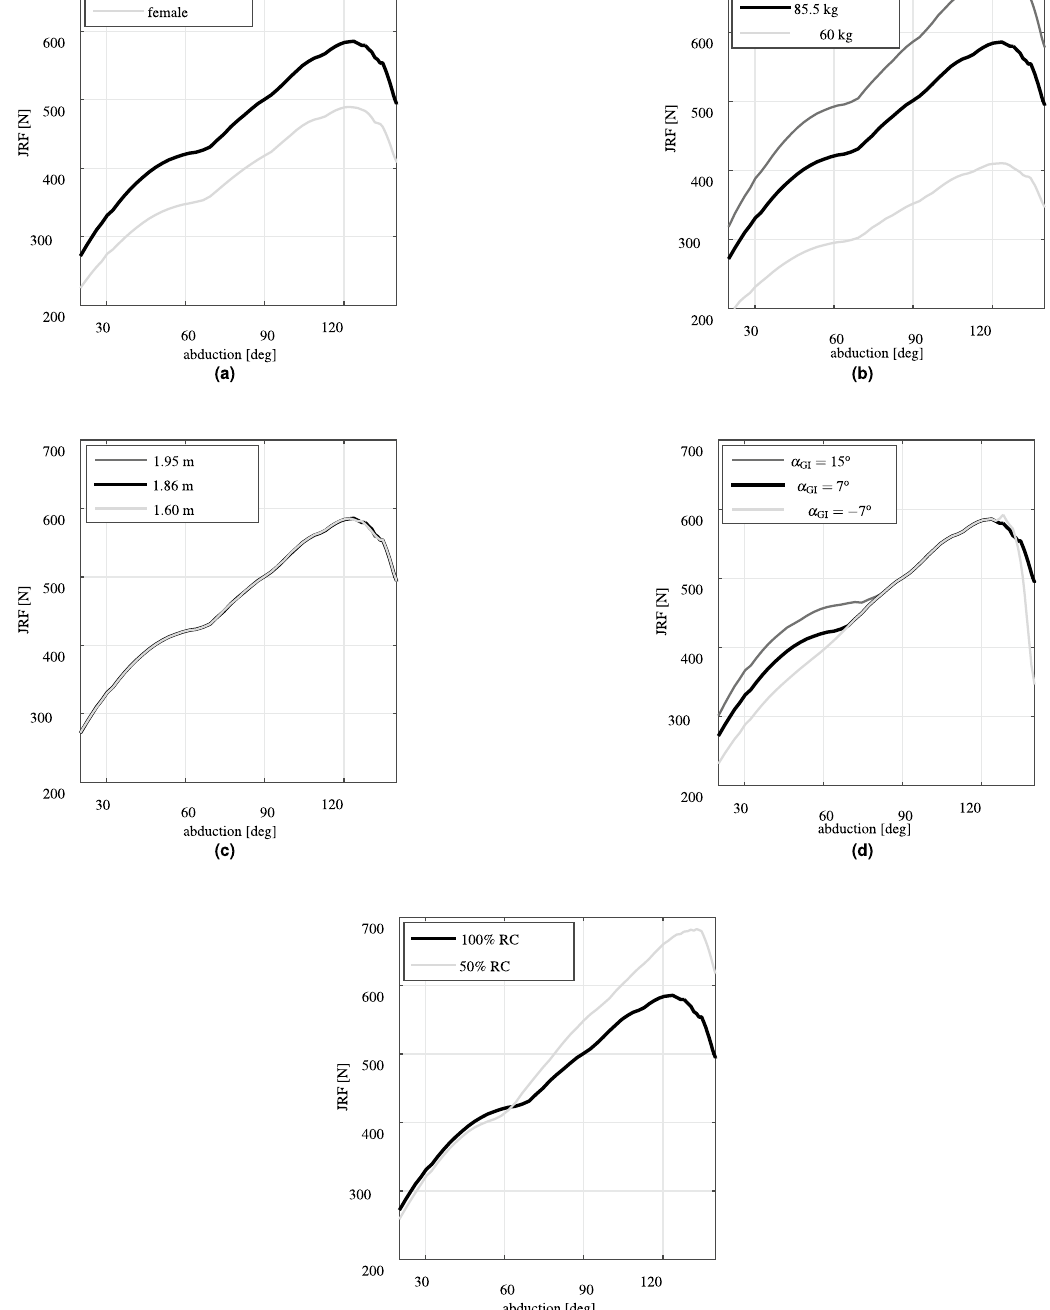
Figure 5. Evaluations of the effects of subject specific parameters on the JRF predictions during abduction motion in the scapula plane. ( a ) Gender, ( b ) weight, ( c ) height, ( d ) glenoid inclination, and ( e ) 50% reduction in PCSAs of RC